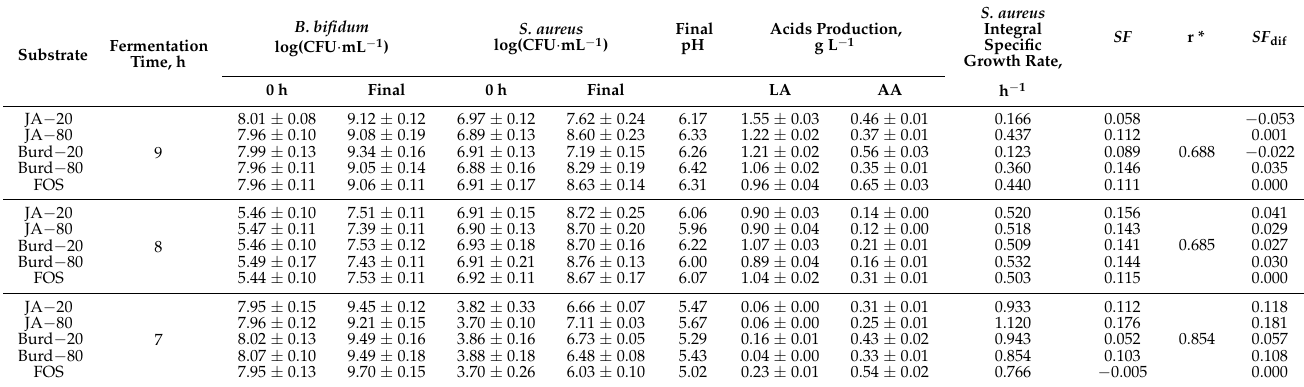
Table 4. The growth characteristics of cultures and synbiotic factors for the carbohydrate fraction of aqueous extracts of Jerusalem artichoke and burdock precipitated with 20% or 80% ethanol and with the control experiments with FOS (Orafti P95) with varied initial counts of bifidobacteria and Staphylococcus and fermentation times.